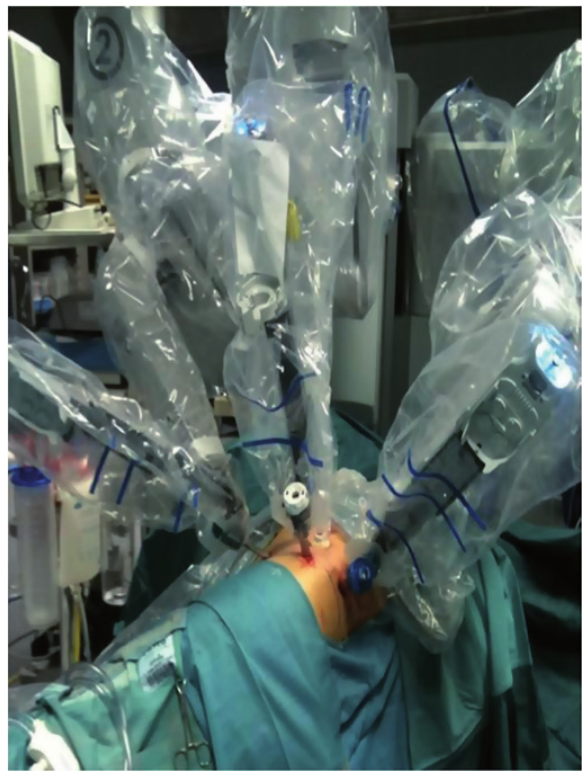
Figure 3 - Da vinci si ® robotic surgical system